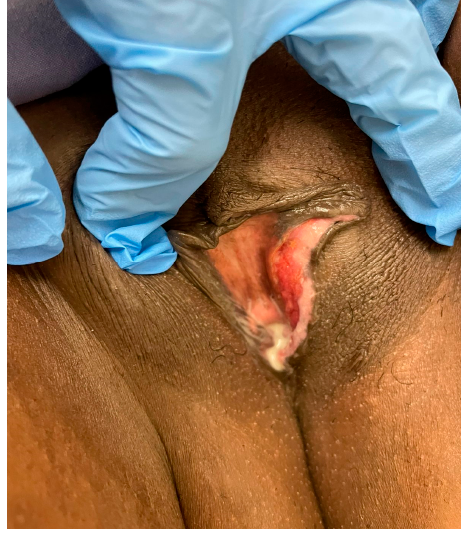
Figure 3. After 3 cycles of carboplatin/paclitaxel.